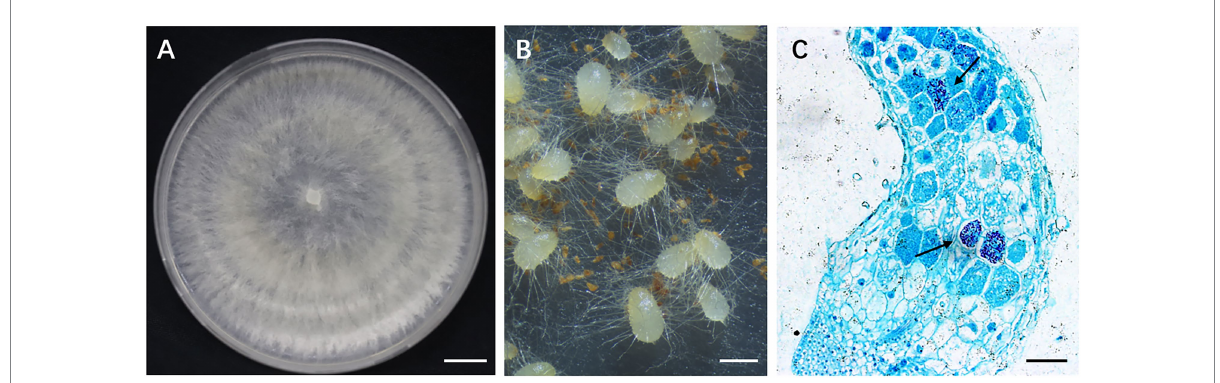
FIGURE 2 Gymnadenia conopsea seed germination promoted by GS2. (A) Colony morphology of GS2; (B) germinating seeds of G. conopsea , protocorms formed 30 days after incubated with inoculum of GS2; (C) cross section of protocorm. Large number of pelotons (arrow) were observed in cortical cells (arrow). Bar A = 1 cm; B = 1 mm; C = 200 μ